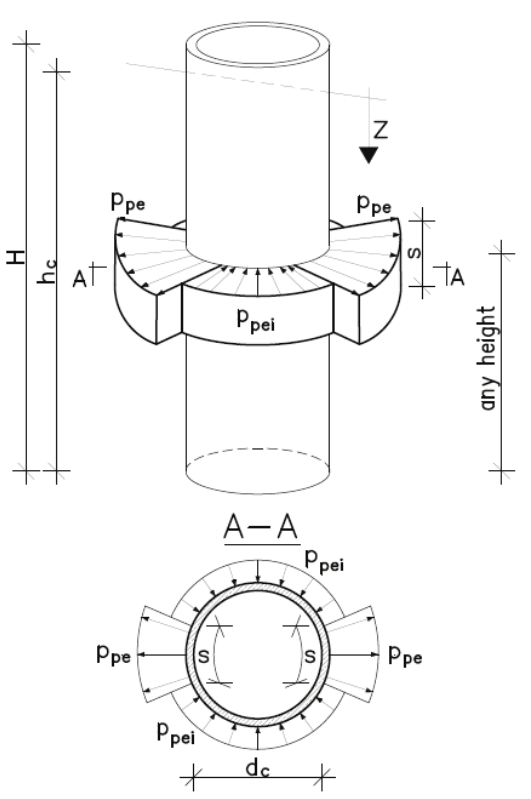
Figure 1: Distribution of local pressure in the cylindrical silo